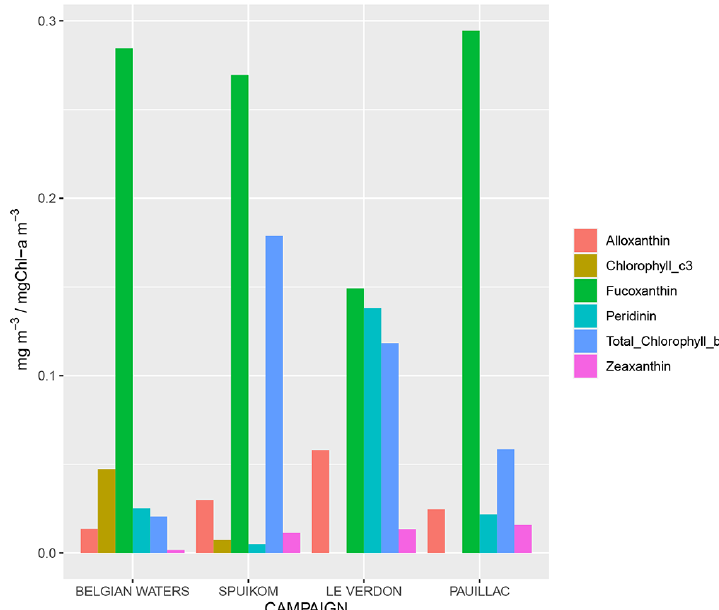
Figure 5. For each campaign, average concentration of alloxanthin, fucoxanthin, peridinin, chlorophyll c 3 , zeaxanthin, and total chlorophyll b normalized by the concentration in chlorophyll- a .